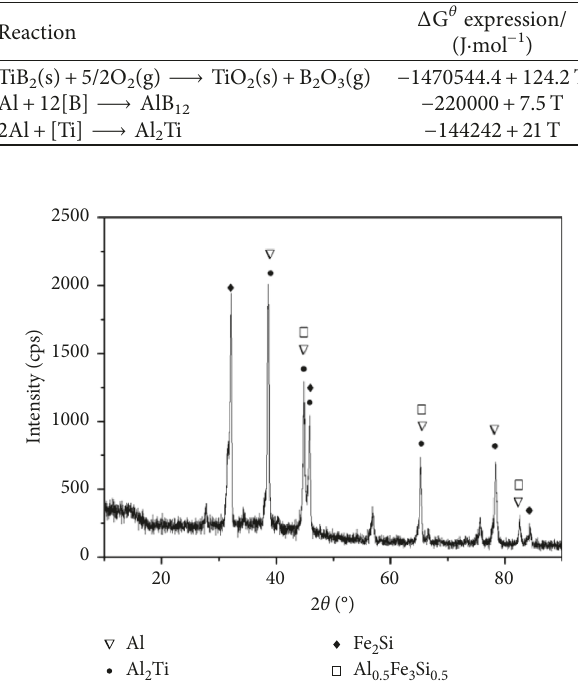
Figure 4: XRD results of the weld